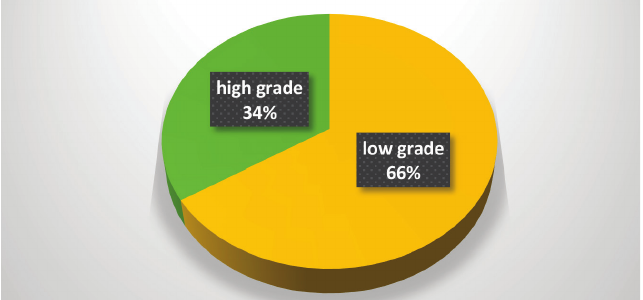
Figure 2. Distribution of CRC patients based on tumor grading (High grade ad low grade)